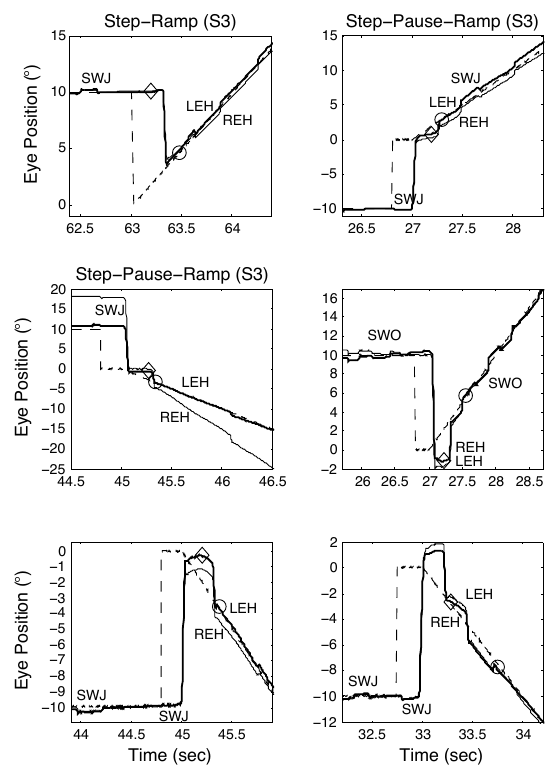
Figure 8. Examples of SR (top left) and SPR responses from S3 containing proximal saccades demonstrating both classical and other types of response, including those containing disconjugate saccades, square-wave jerks (SWJ), and square-wave oscillations (SWO). See text for